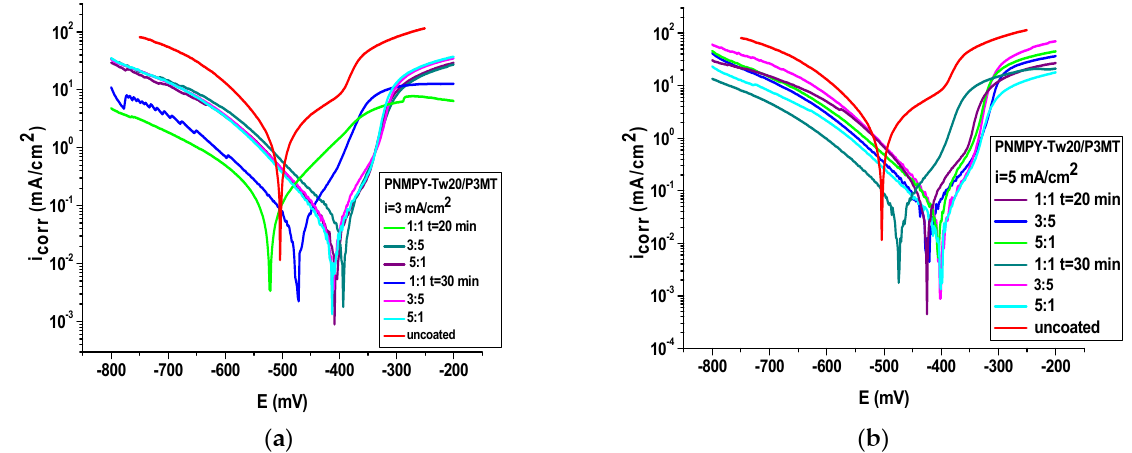
Figure 5. Polarization curves of PNMPY-TW20/P3MT coated and uncoated on OLC 45 electrode in 0.5 M H 2 SO 4 by galvanostatic proceeding at ( a ) 3 mA/cm 2 and ( b ) 5 mA/cm 2 current density to various molar ratio, and the electrodeposition has been permitted for 20 and 30 min.